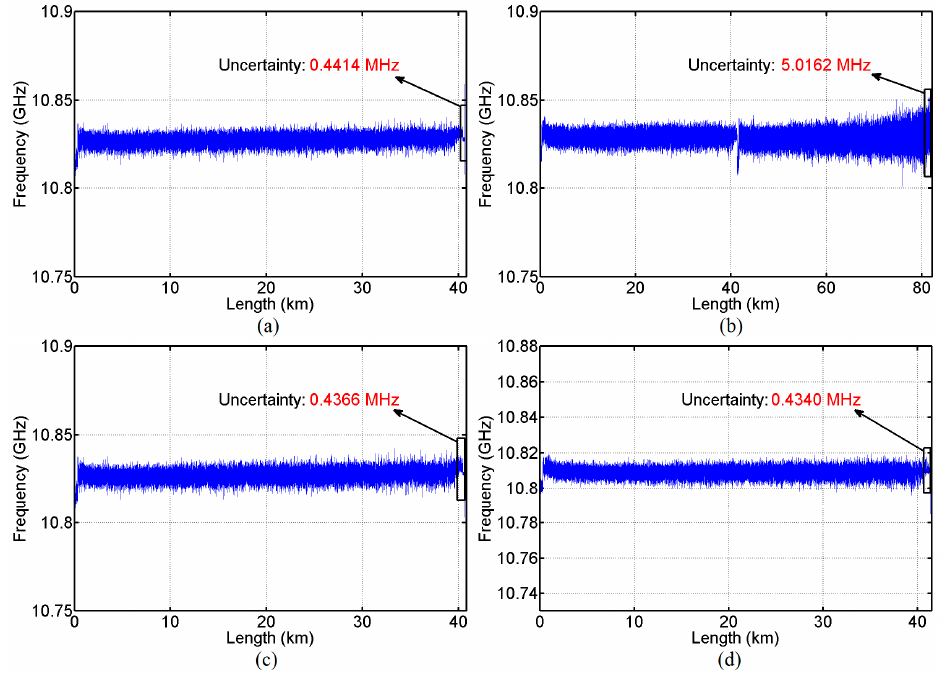
Figure 7. BFS versus distance of ( a ) the 40.6 km SMF in the unidirectional BOTDA system; ( b ) the 81.9 km SMF in the unidirectional BOTDA system; ( c ) the λ 1 channel in the BD-BOTDA system along FUT I; and ( d ) the λ 2 channel in the BD-BOTDA system along FUT III.